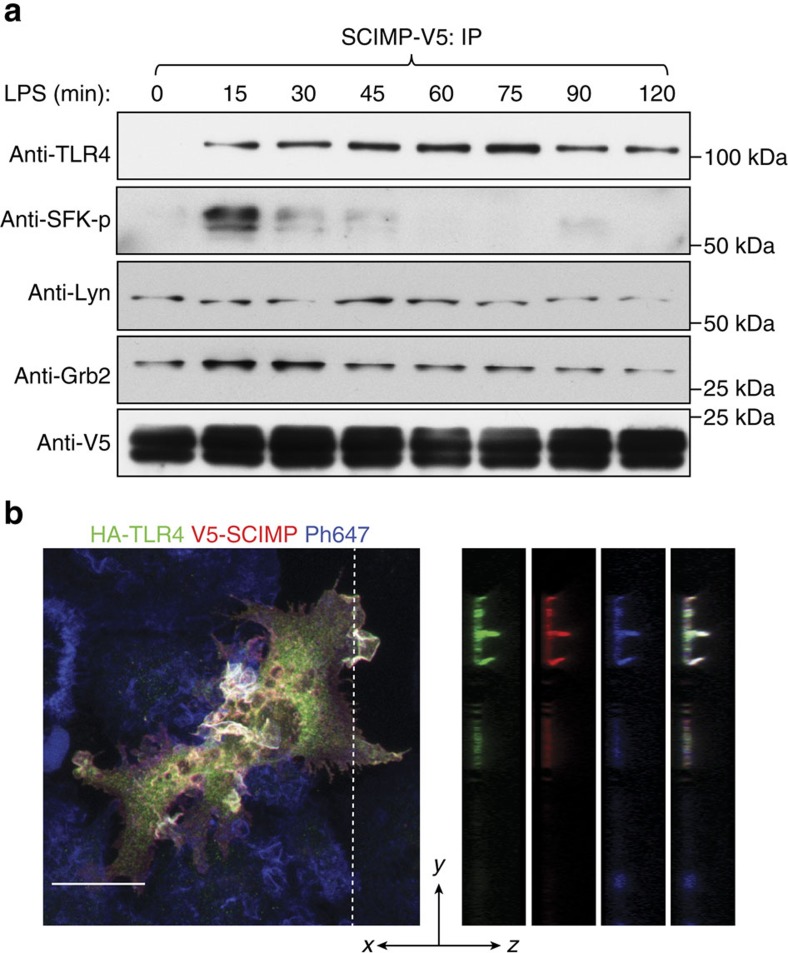
SCIMP is recruited to TLR4 in macrophages on LPS activation.(a) V5-labelled SCIMP was stably expressed in RAW264.7 macrophages, cells were treated with LPS, and at the indicated times, the V5 antibody was used for immunoprecipitation. Samples were probed for TLR4, pSFK(Y416), Lyn, Grb2 and V5-SCIMP. (b) Confocal imaging of LPS-treated (30 min) RAW264.7 cells transiently co-expressing TLR4-HA (green) and SCIMP-V5 (red), with phalloidin (blue). TLR4 and SCIMP are colocalized (white) on dorsal surface ruffles, as shown for separate channels in the Z projections. Data in a and b are representative of three independent experiments. The scale bar in b represents 10 μm.